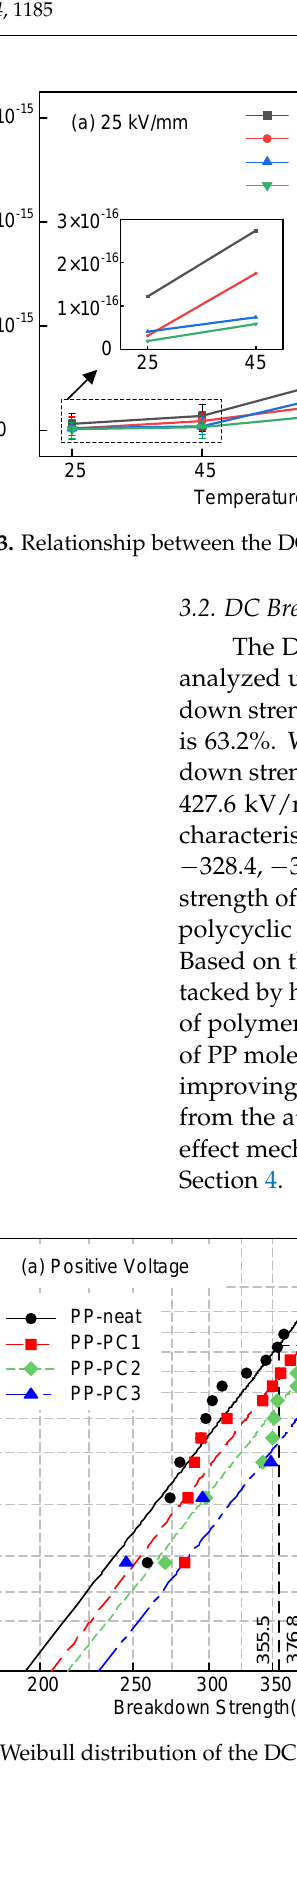
Figure 4. Weibull distribution of the DC breakdown strength of samples at 85 °C: ( a ) positive voltage; ( b ) negative voltage.